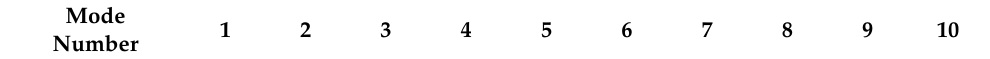
Table 7. Measured frequencies of the cable network obtained from free vibration.